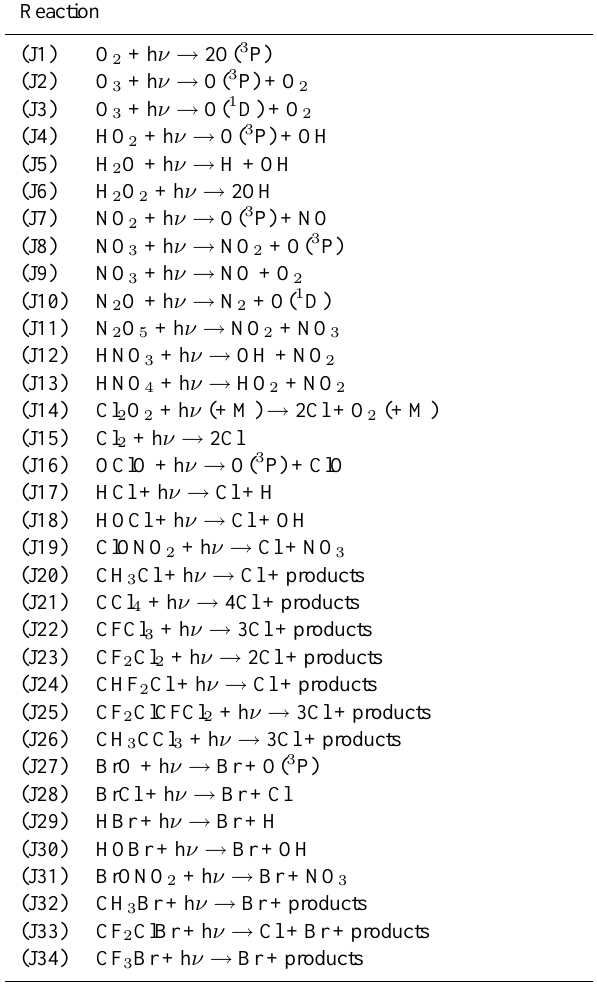
Table 2. Photolysis reactions included in the model